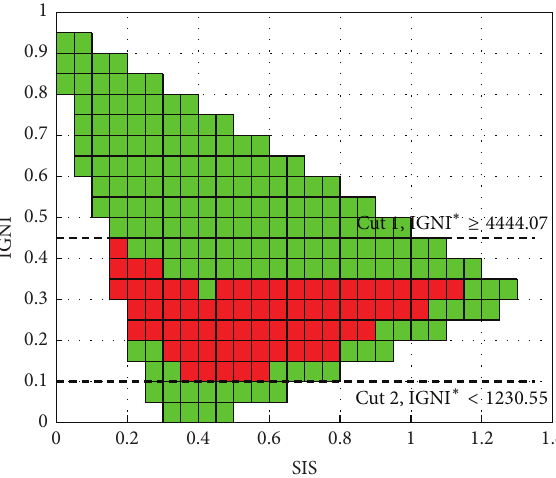
Figure 6: Cluster representation of the failure domain (red) and safety domain (green) for the sequence [ INI SIS IGNI ] (SIS ∗ , IGNI ∗ : in coordinate system defined by principal components of the dataset), axes scaled between 0 and 1.